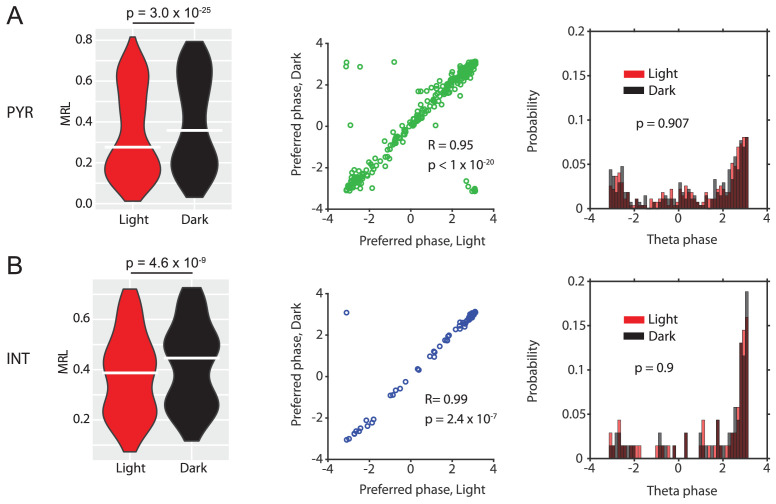
Data for n = 273 putative principal neurons (PN) (A) and n = 69 putative interneurons (IN) (B).Violin plots show theta-phase locking of theta rhythmic PNs or theta rhythmic INs during light and dark conditions; p-values from Wilcoxon signed-rank test. Scatter plots show preferred LFP theta phases during light and dark for PNs (green) or INs (blue). Note the high circular-linear correlations for PNs and INs. Third panels in A and B show probability-normalized histograms of preferred LFP theta phases during light and dark for PNs and INs. Note that the majority of both PNs and INs preferentially fire around the trough of layer II/III LFP theta oscillations, and a minority preferred firing around the peak. No significant differences were observed between light and dark conditions in PNs or INs; p-values from Kolmogorov-Smirnov test.